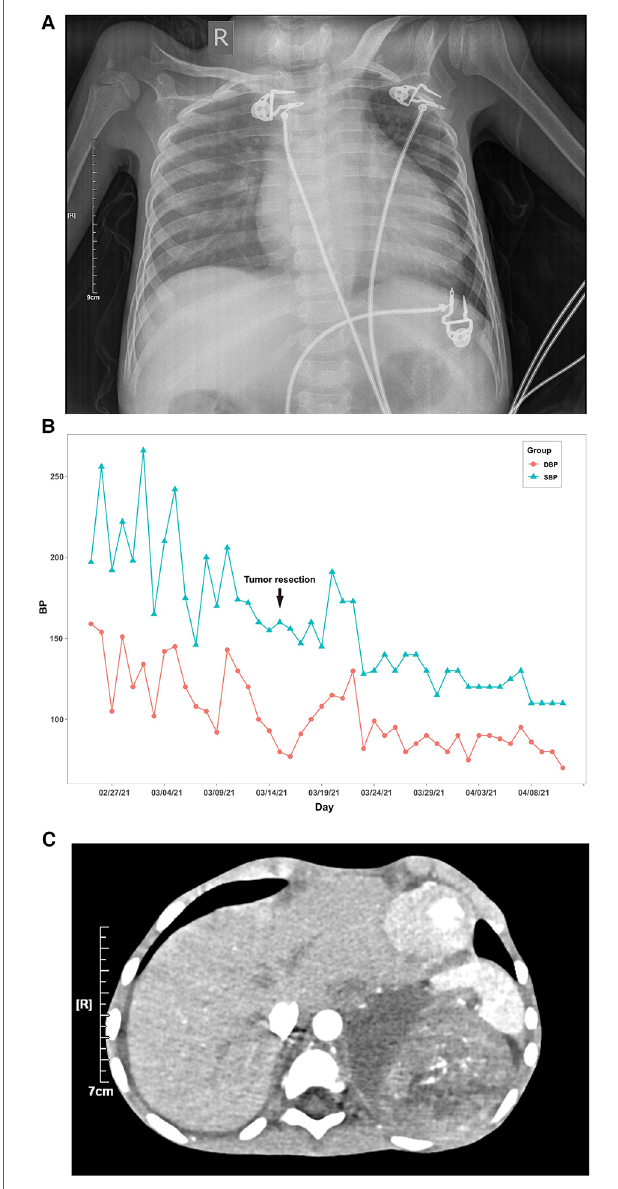
FIGURE 1 Blood pressure value, chest x-ray and abdominal computed tomography (CT) scan of the patient. ( A ) Line chart of the patient ’ s daily maximum systolic and diastolic blood pressure. ( B ) In chest x-ray, the scattered patches revealed increased density and right pleural effusion, and the cardiac shadow was enlarged. ( C ) In the abdominal computed tomography (CT) scan, there was a right pleural effusion and a soft tissue density mass shadow behind the left peritoneum measuring 8.7 cm×7.1 cm×9.5 cm, with a CT value of approximately 28 – 46 HU. Internal density was varied, with calci fi ed density shadow in certain areas. One possibility is neuroblastoma. The pressure is on the left kidney and